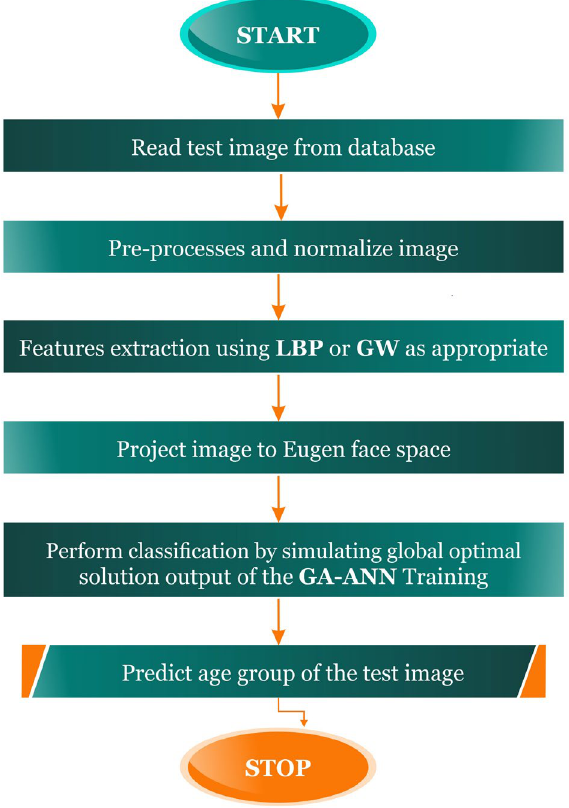
Figure 12. The developed GA-ANN-based age estimation system’s process